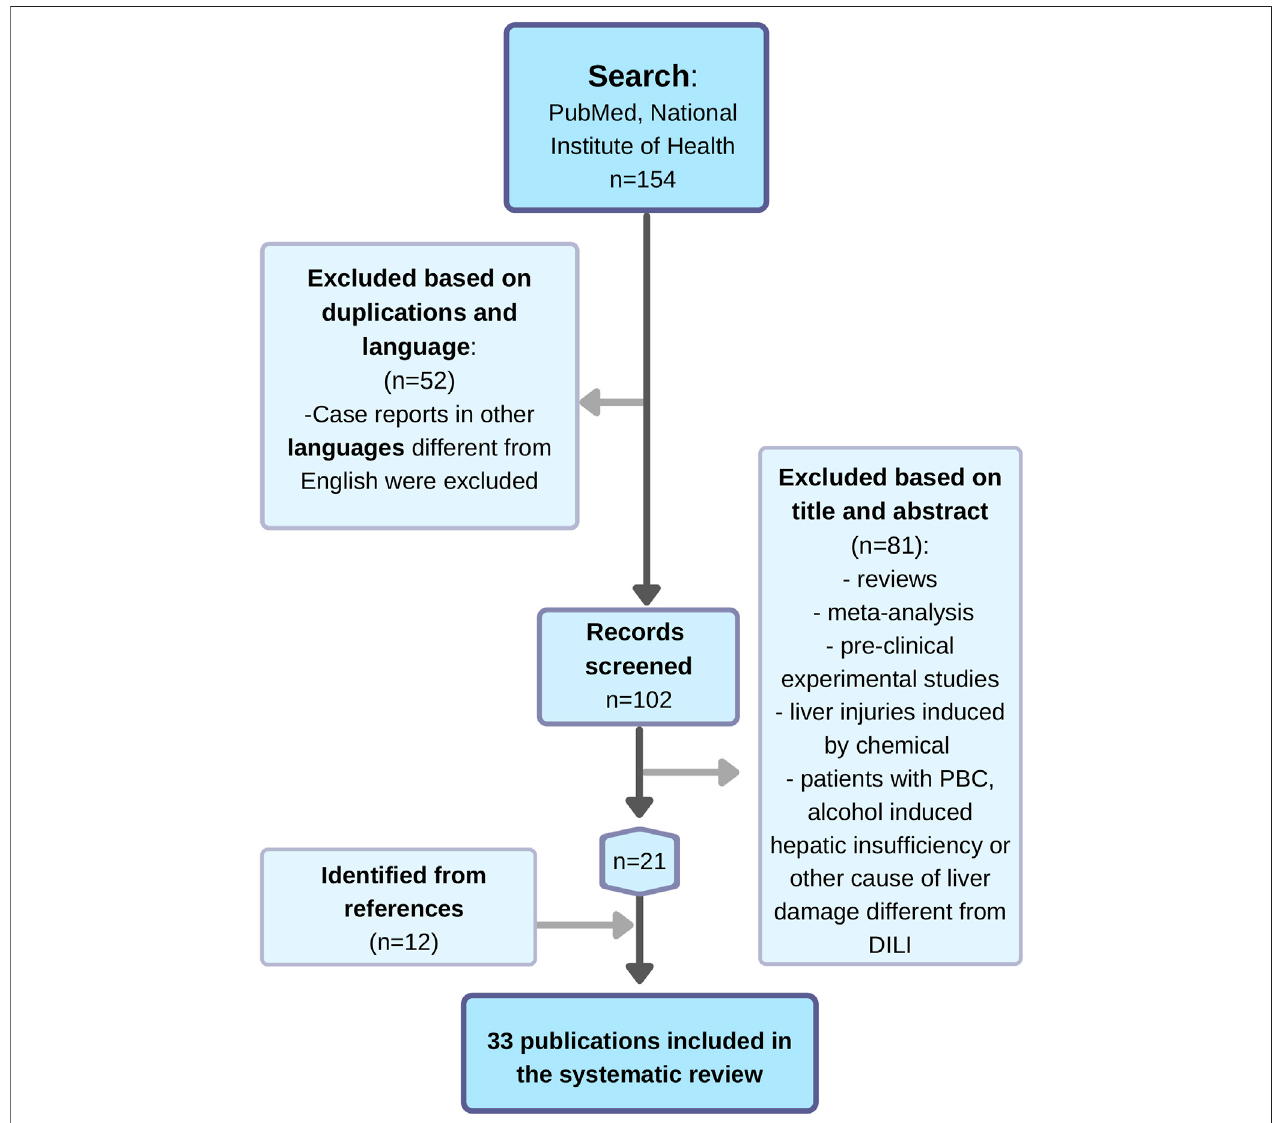
FIGURE 1 | Flow chart of the search of publications about the role of UDCA in DILI treatment and prevention.